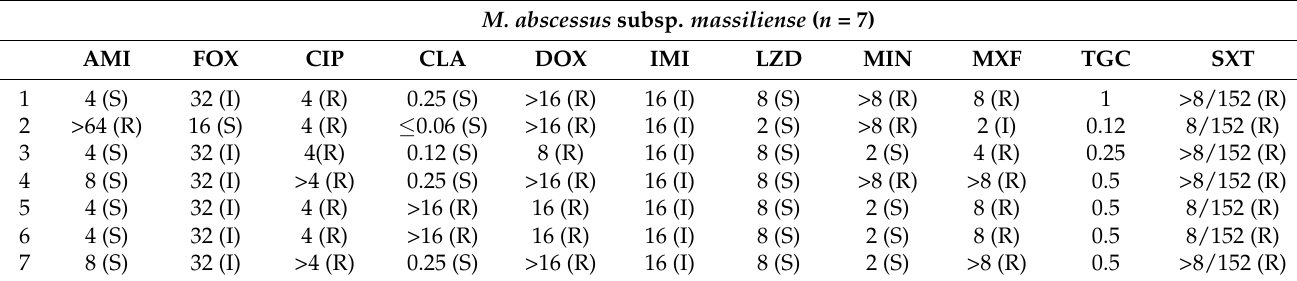
Table 6. Results of in vitro susceptibility testing for M. abscessus subsp. massiliense strains.